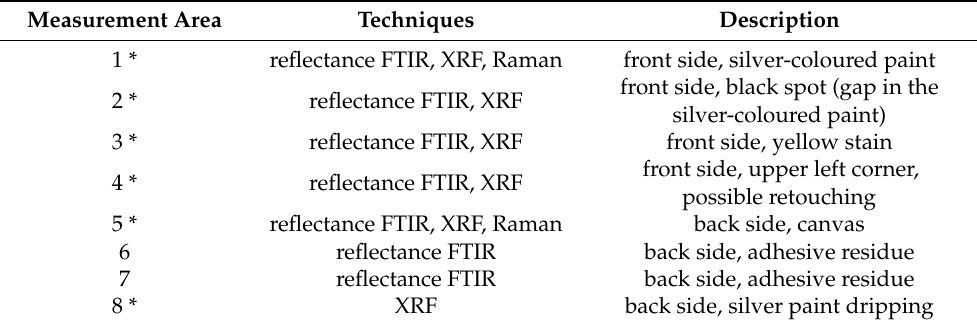
Table 1. Areas of Lucio Fontana’s monochrome silver painting on which in situ spectroscopic measurements were performed. Measurement Area Techniques Description 1 * reflectance FTIR, XRF, Raman front side, silver-coloured paint front side, black spot (gap in the 2 * reflectance FTIR, XRF silver-coloured paint) 3 * reflectance FTIR, XRF front side, yellow stain front side, upper left corner, 4 * reflectance FTIR, XRF possible retouching 5 * reflectance FTIR, XRF, Raman back side, canvas 6 reflectance FTIR back side, adhesive residue 7 reflectance FTIR back side, adhesive residue 8 * XRF back side, silver paint